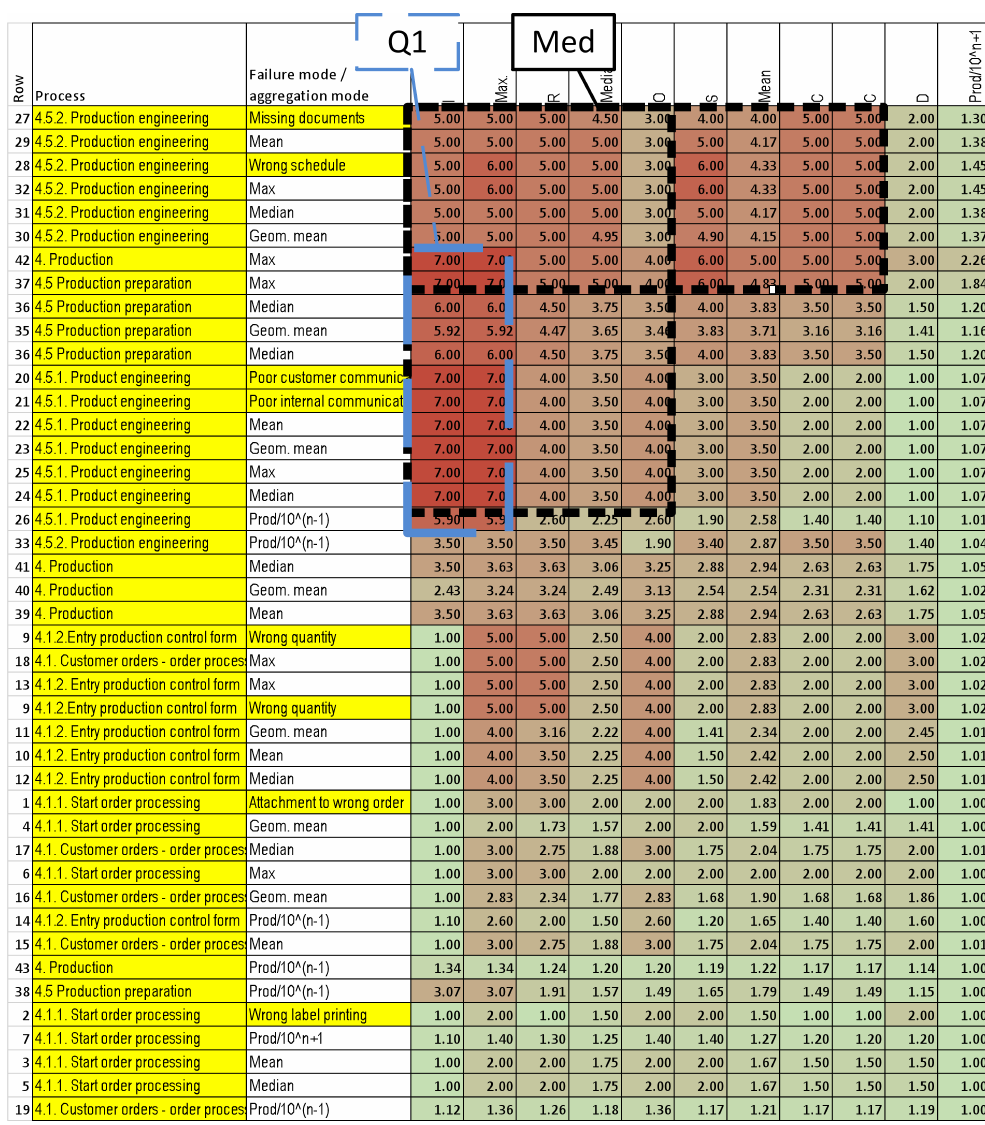
Figure 5. The unsupervised risk evaluation results. The seriated and biclustered risk-level matrices with τ = 0.5 (Med) and τ = 0.75 (Q1) are